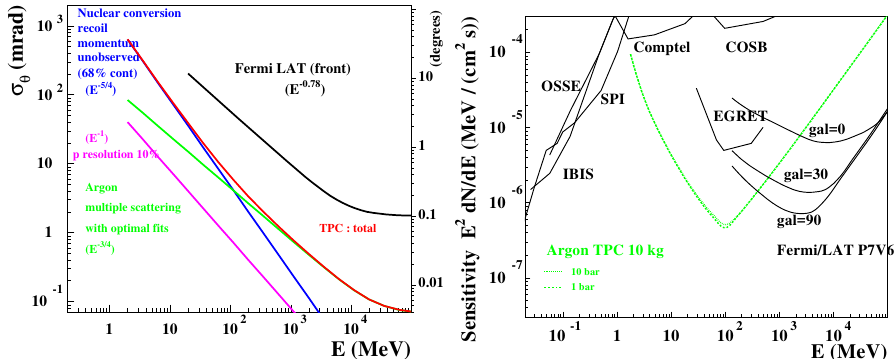
Figure 1. ( Left ) the three contributions to the single-photon angular resolution, namely the lack of recoil ion momentum measurement (blue), the single-track angular resolution (green), the single-track momentum resolution (cyan, assumed here to be of 10%) and their total (red), as a function of the incoming photon energy, compared to that of the Fermi-Large Area Telescope (LAT); ( Right ) the point-like source sensitivity of a 10kg gas time-projection chamber (TPC) telescope, computed à la Fermi-LAT, as a function of the incoming photon energy, compared to that of past and present telescopes. Both adapted from